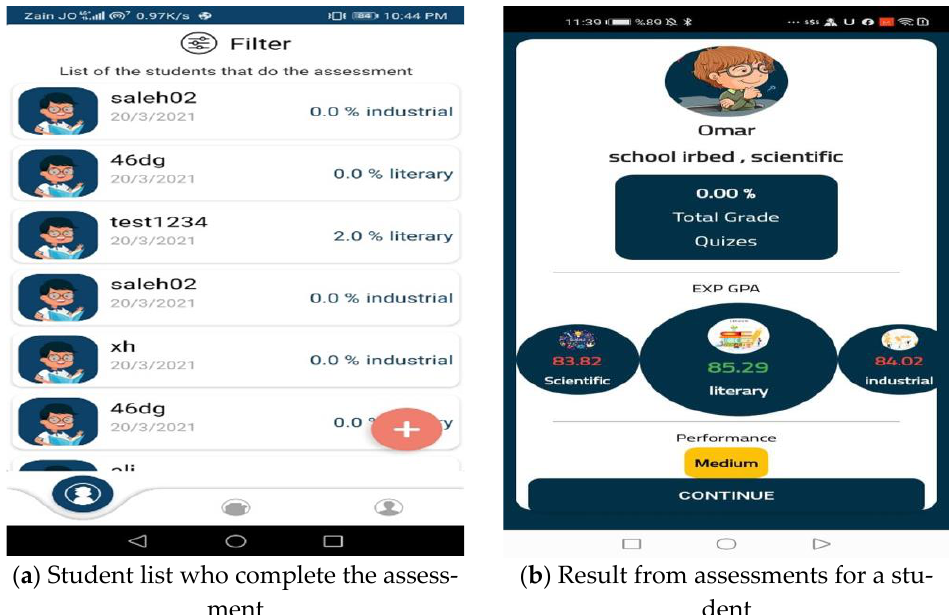
Figure 7. A screen of students’ names with their specialization and marks in level exams, the average of the basic subjects, and the students’ performance prediction.